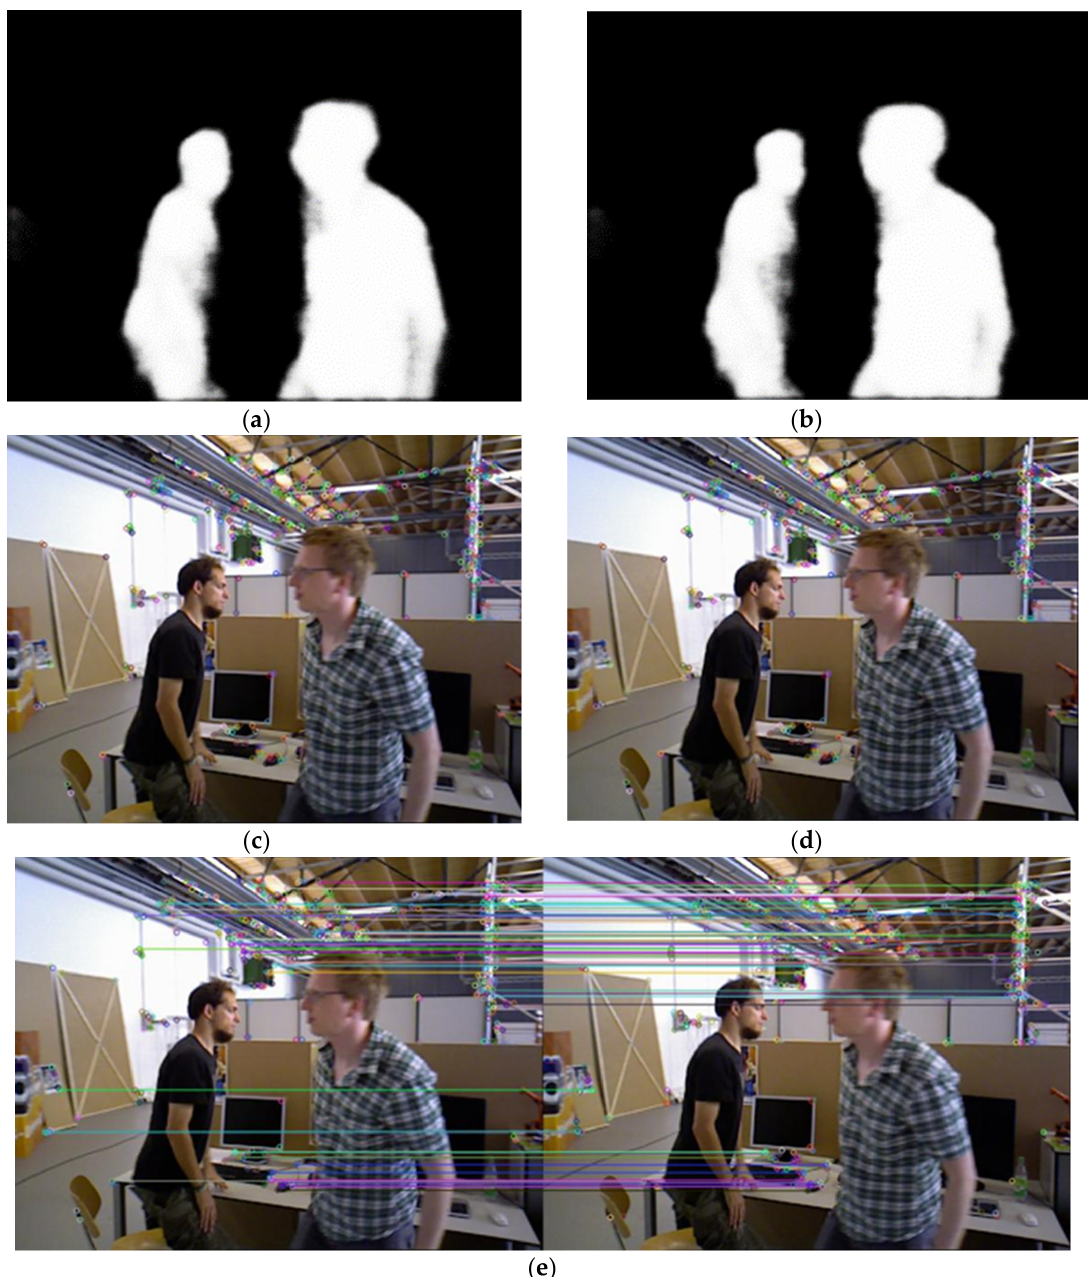
Figure 10. Results of feature extraction and matching based on proposed SLAM: ( a ) Figure for dynamic dot culling of first frame; ( b ) Figure for dynamic dot culling of second frame; ( c ) Feature points extracted after screening of first frame; ( d ) Feature points extracted after screening of second frame; ( e ) The ORB matching results of original Figures 1 and 2 after screening.